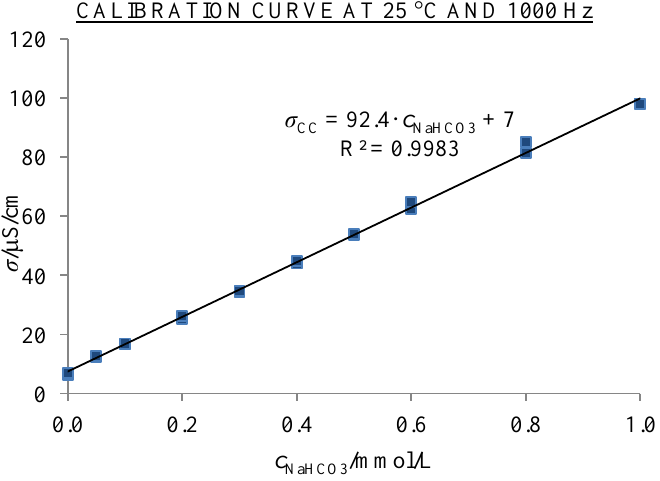
Figure 14. Calibration curve of NaHCO points in the graph represent individual